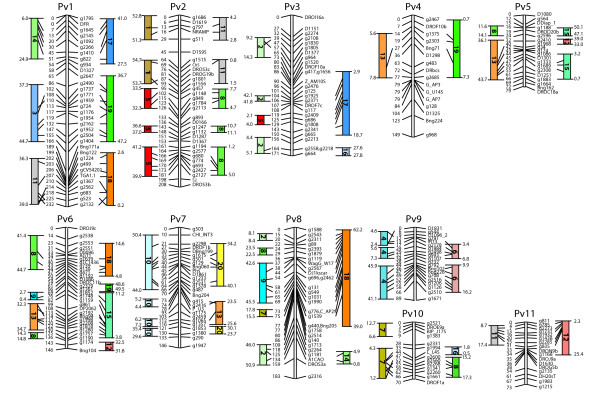
Syntentic relationships of soybean relative to the common bean genetic map. A common bean genetic map anchors corresponding syntenic regions of the soybean 1.01 genome build. The location (in megabase pairs) of each soybean fragment straddling the common bean linkage is noted at the beginning and end of the homology.